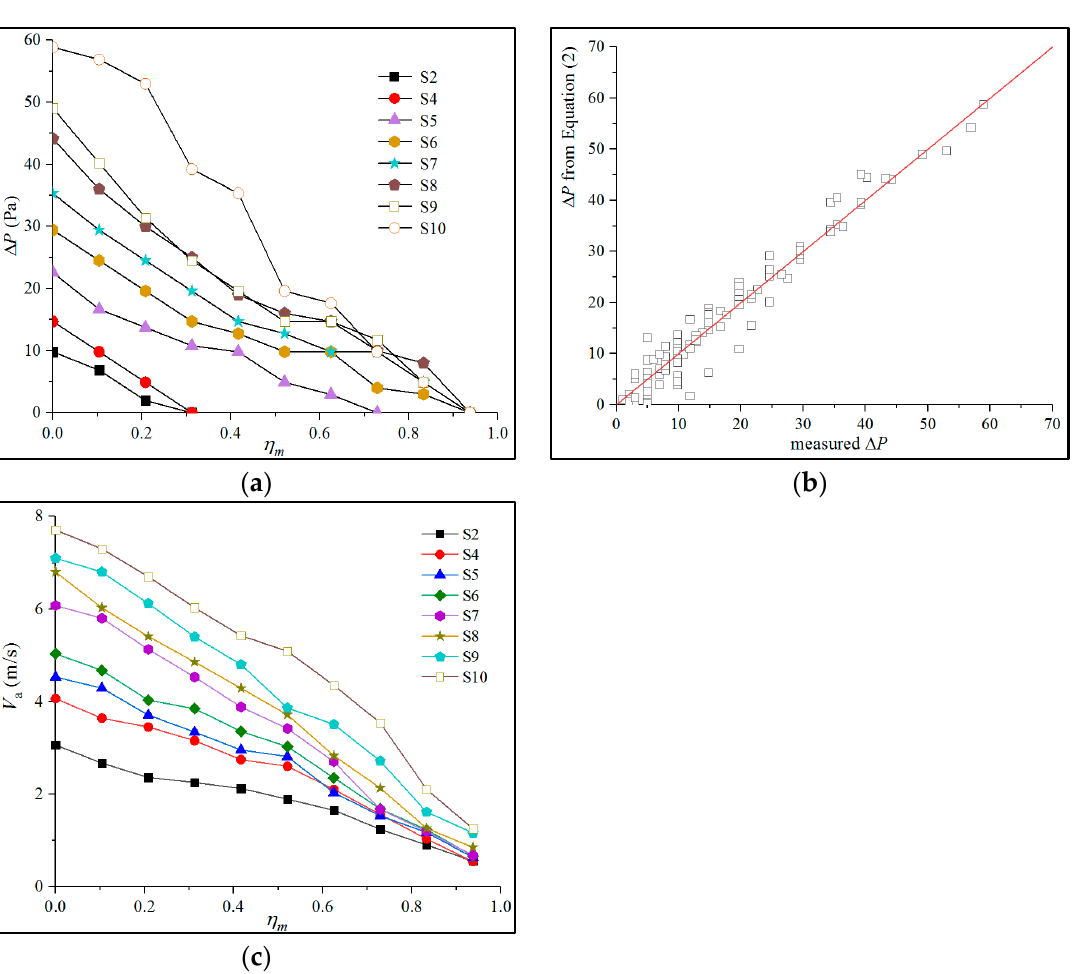
Figure 3. Δ P and air velocity at different atmospheric pressures. ( a ) Changes in Δ P ; ( b ) Δ P computed Figure 3. ∆ P and air velocity at different atmospheric pressures. ( a ) Changes in ∆ P ; ( b ) ∆ P computed by using Equation (2); ( c ) air velocity in the shaft. by using Equation (2); ( c ) air velocity in the